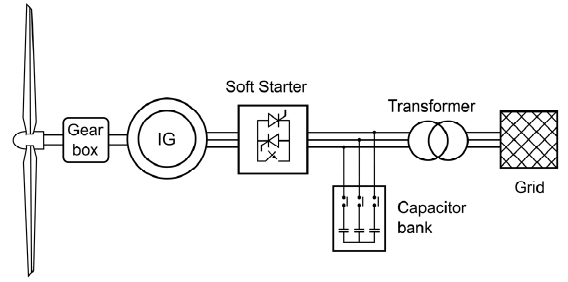
Figure 2. Diagram of the squirrel cage induction generator (SCIG) wind turbine.